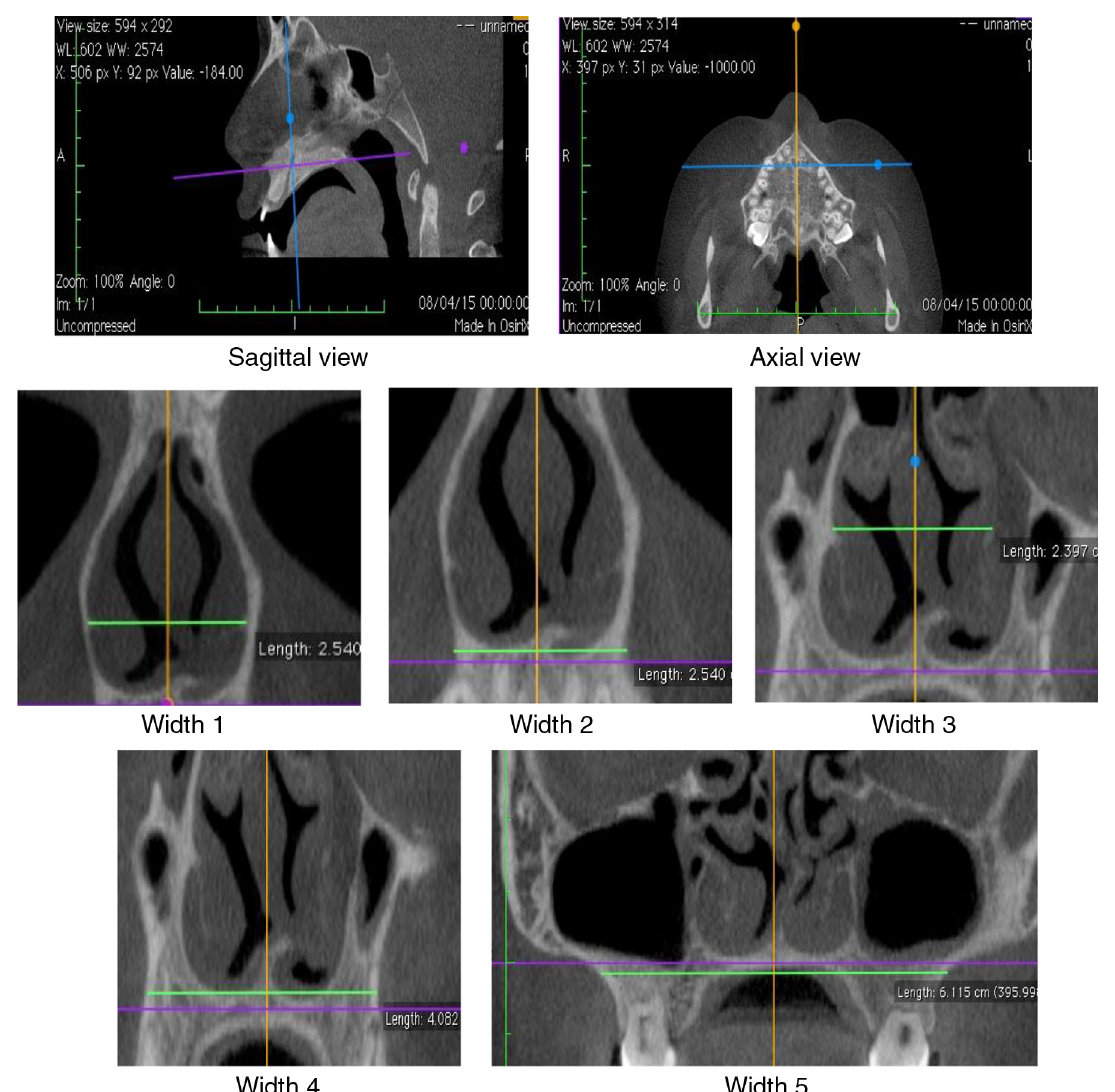
Figure 1 Sagittal and axial planes used for protocol for the reformatted coronal planes (Widths 1---5). Widths 1 and 2 --- head of the inferior turbinate; Widths 3 and 4 --- head of the middle turbinate; Width 5 --- maxillary bone.